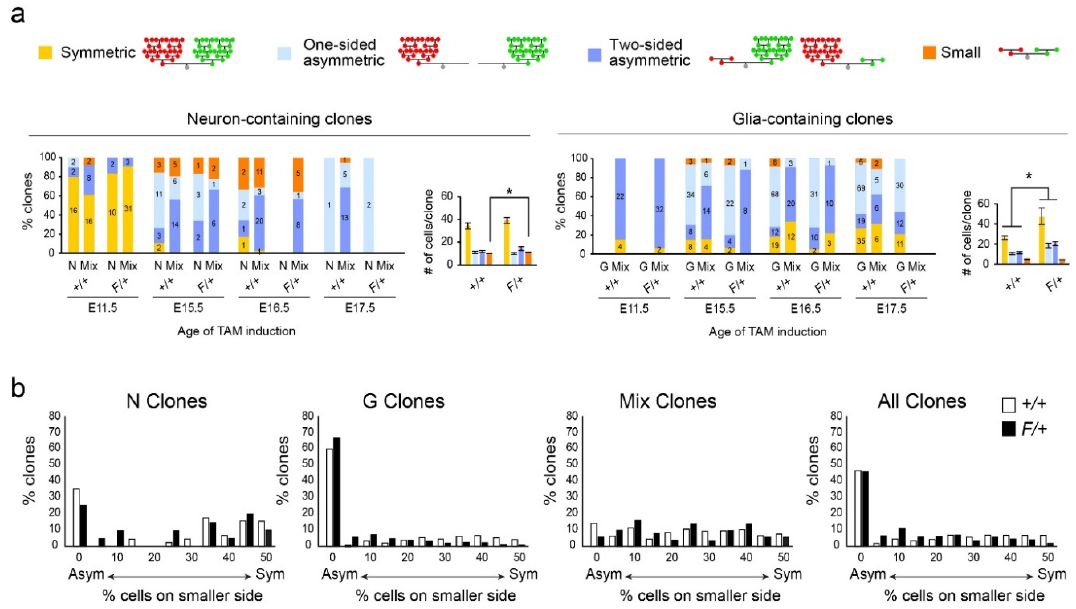
Figure 4. Analysis of clonal MADM data in Neuron-containing and Glia-containing clones in the dorsolateral cortices. ( a ) Analysis of symmetry in clones at different time points and genotypes. Data are percentages of clones that form the different categories of clones as indicated. Numbers in the bars indicate the numbers of clones that fall into each category. Charts present numbers of cells per clone for each category of neuron-containing and glia-containing clones for all time points combined. Data are mean ± sem. *, rank-sum test, p < 0.05. ( b ) Percentages of clones across a gradient of asymmetry depicted on the x-axes (0 = one-sided asymmetric; 50 = symmetric) in +/+ and F/+ cortices. Data are shown separately for each clone type and for all clones combined. The majority of G clones are one-sided asymmetric in both genotypes (green and red MADM cells are combined).